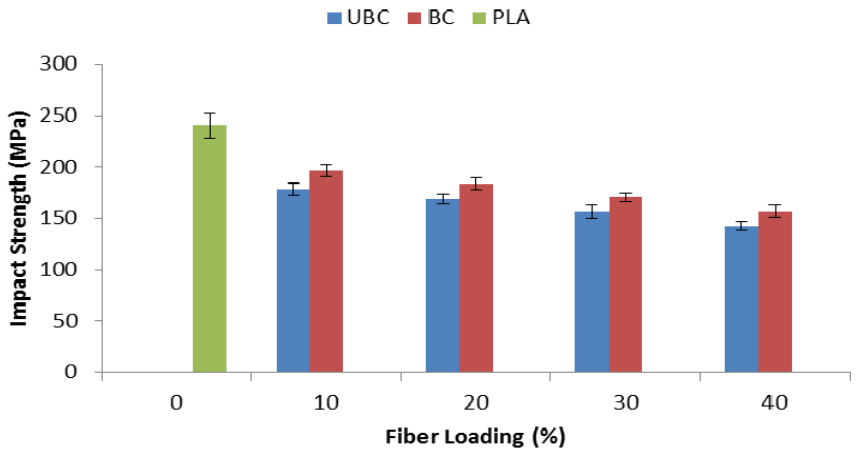
Figure 9. Impact strength of pure PLA, UBC and BC